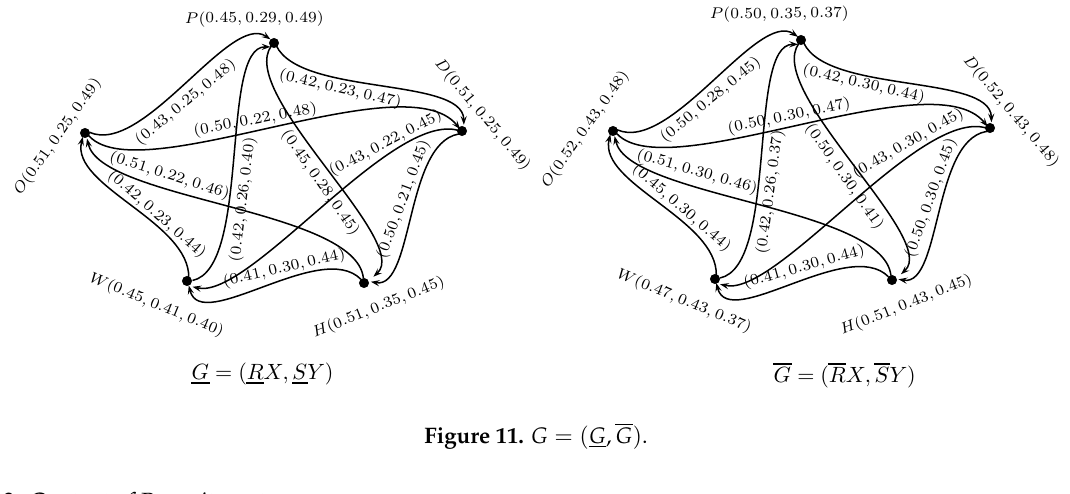
Figure 11: G = ( G,G ) Figure 11. G = ( G , G )